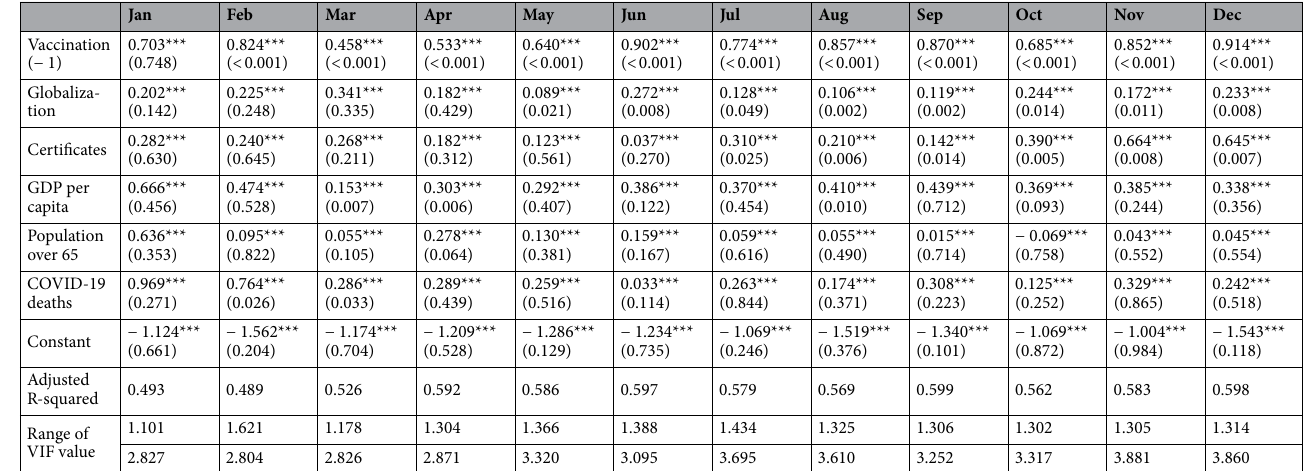
Table 3. Relationship between COVID-19 vaccination and globalization (coefficient and probability OLS regressions). Probabilities are in parentheses. ***Statistical significance at the 1%.